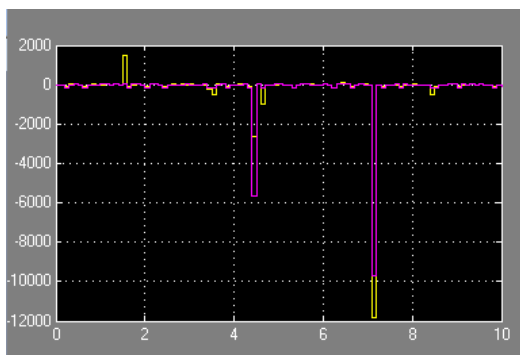
Figure 10. model with using ANN of Scope 3 ‘G 4